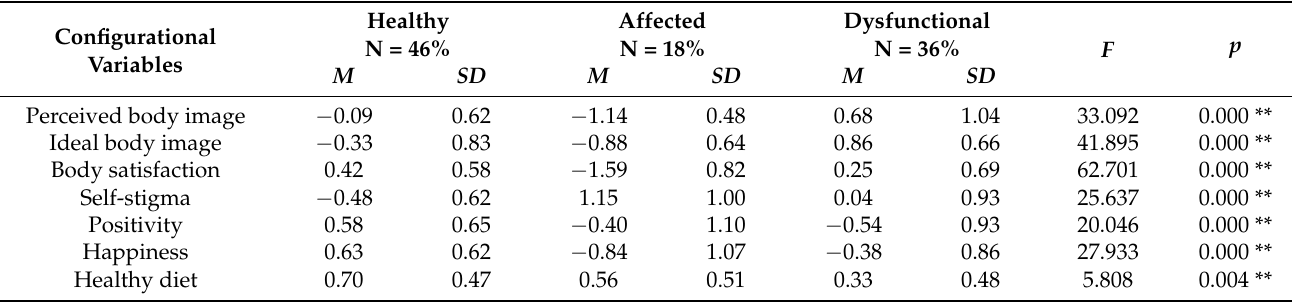
Table 1. Means (centroids), standard deviations, and between-group comparisons (final ANOVA) for three clusters (Z